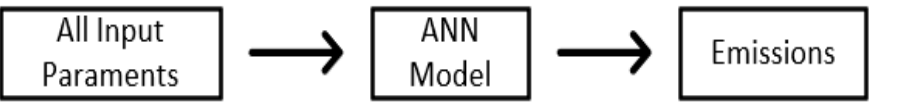
Figure 2. Basic working principle of the proposed algorithm.